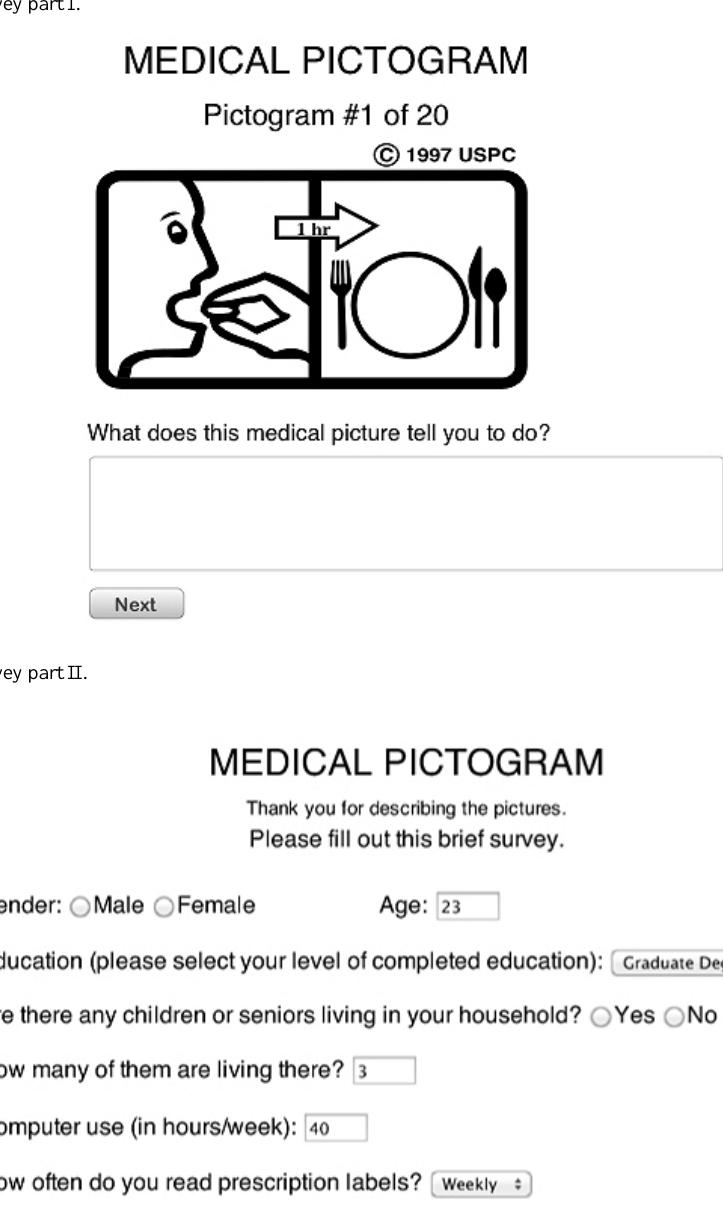
Figure 3. Interface of survey part I.